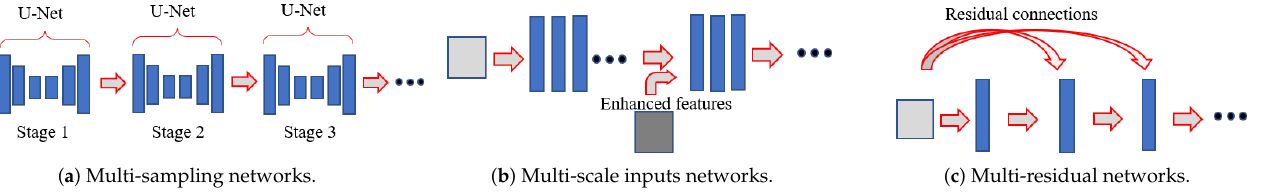
Figure 1. Multi-strategy methods utilised for single image deraining models. Rectangular modules represent one or more layers of neural networks. ( a ) Multi-sampling networks contain repetitive down-up sampling processes and related multiple stages [13,14,22]. ( b ) Multi-scale input networks are based on enhanced features or accumulated information [3,4,11,12,15–17,21,22]. ( c ) Multi-residual networks are based on various residual connections [6,10,13,15,21,22]. Although multi-stragedy methods have visible deraining performance, elaborately designed structures, suitable for a single image, rarely reach real-time inference